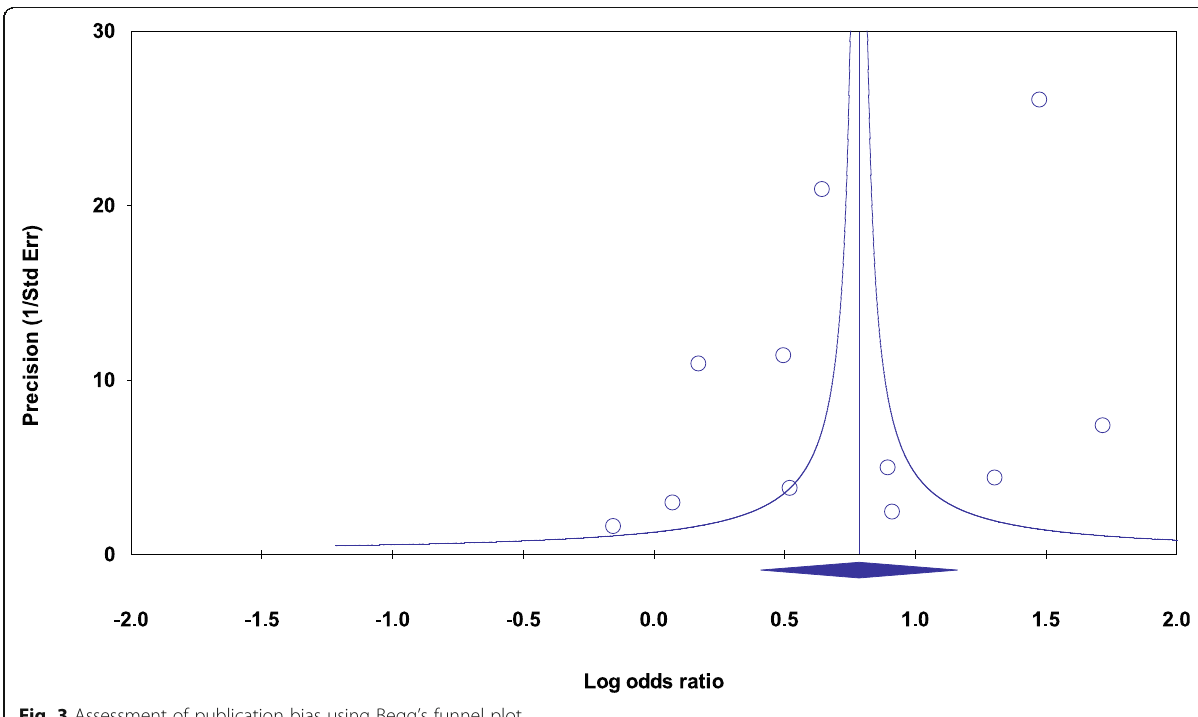
Fig. 3 Assessment of publication bias using Begg ’ s funnel